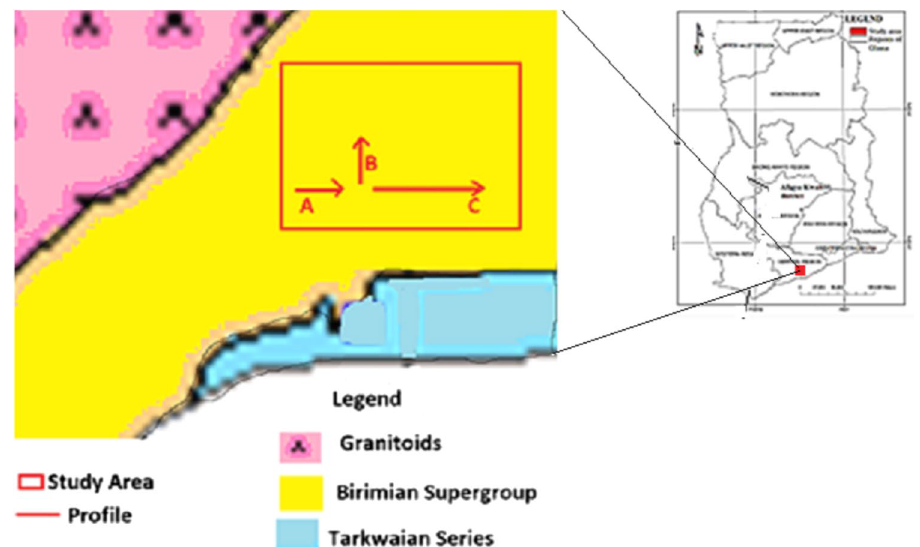
Fig. 1 Geological map of the study area (Modified after GSD